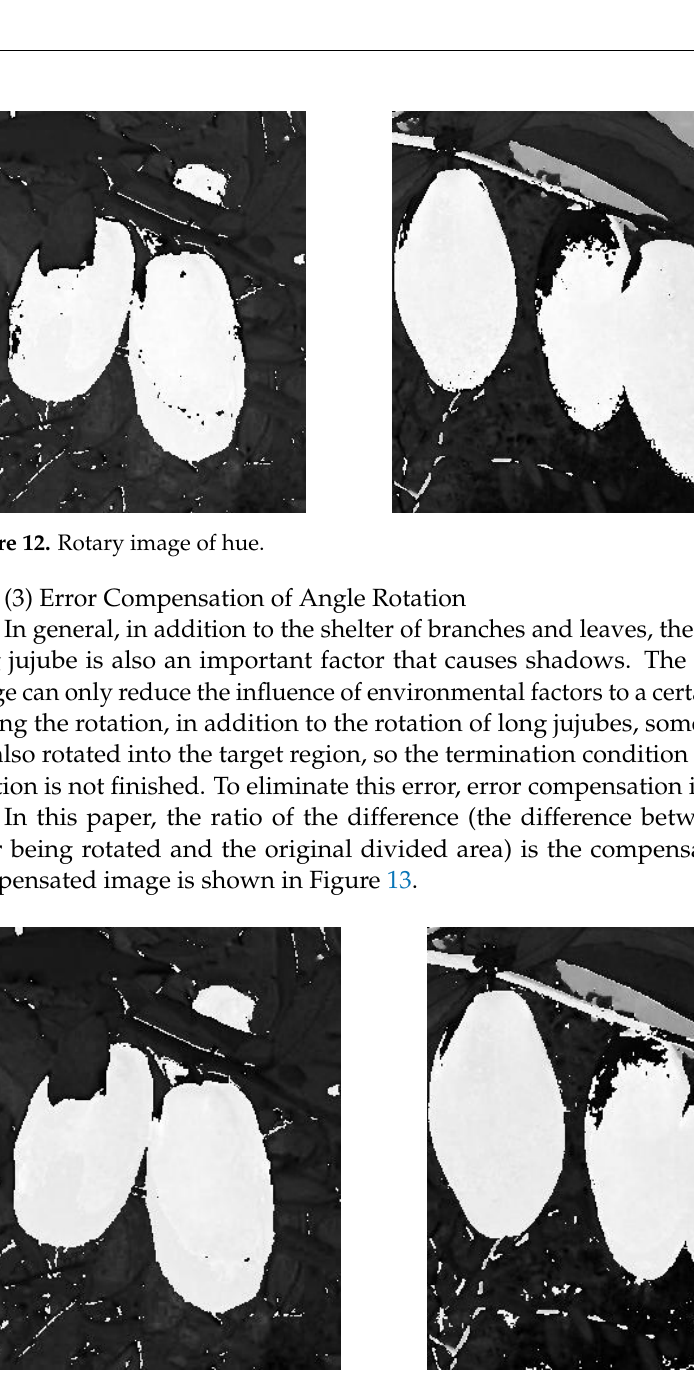
Figure 13. Image with error